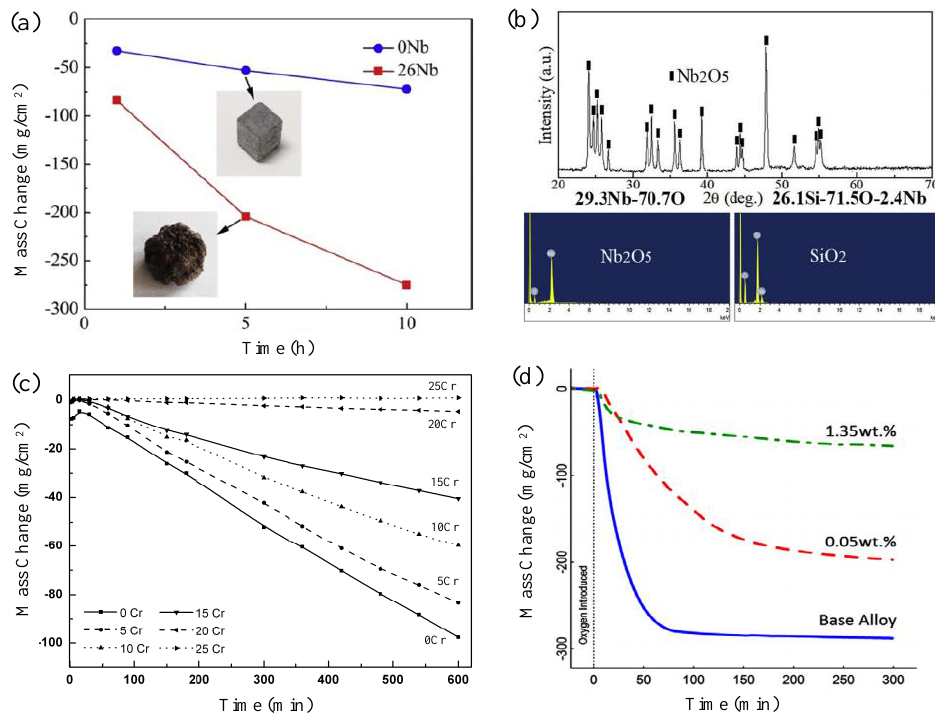
Figure 16. Mass change curves: ( a ) 0 Nb and 26 Nb after oxidation at 1300 ◦ C with macroscopic images of samples oxidized for 5 h, ( c ) Mo-9Si-8B samples with different amounts of Cr oxidized at 750 ◦ C, ( d ) Mo–2Si–1B samples with different amounts of Fe oxidized at 1100 ◦ C; ( b ) XRD and EDX results of 26 Nb oxidized at 1300 ◦ C for 5 h. ( a – d ) reproduced with permission [75,77,78], respectively. Copyright 2019 Elsevier, 2011 Springer Nature and 2012 Elsevier.